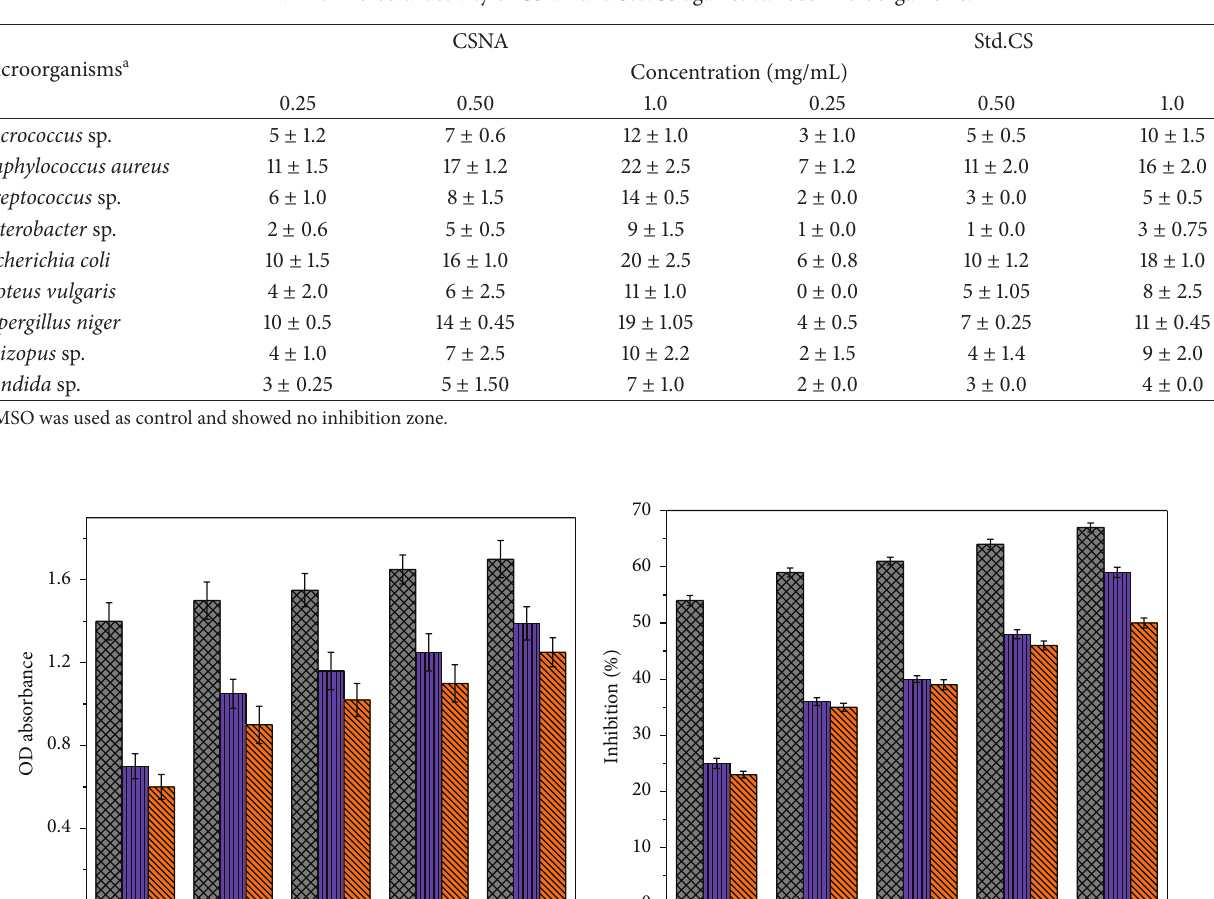
Table 1: Antimicrobial activity of CSNA and Std.CS against various microorganisms.